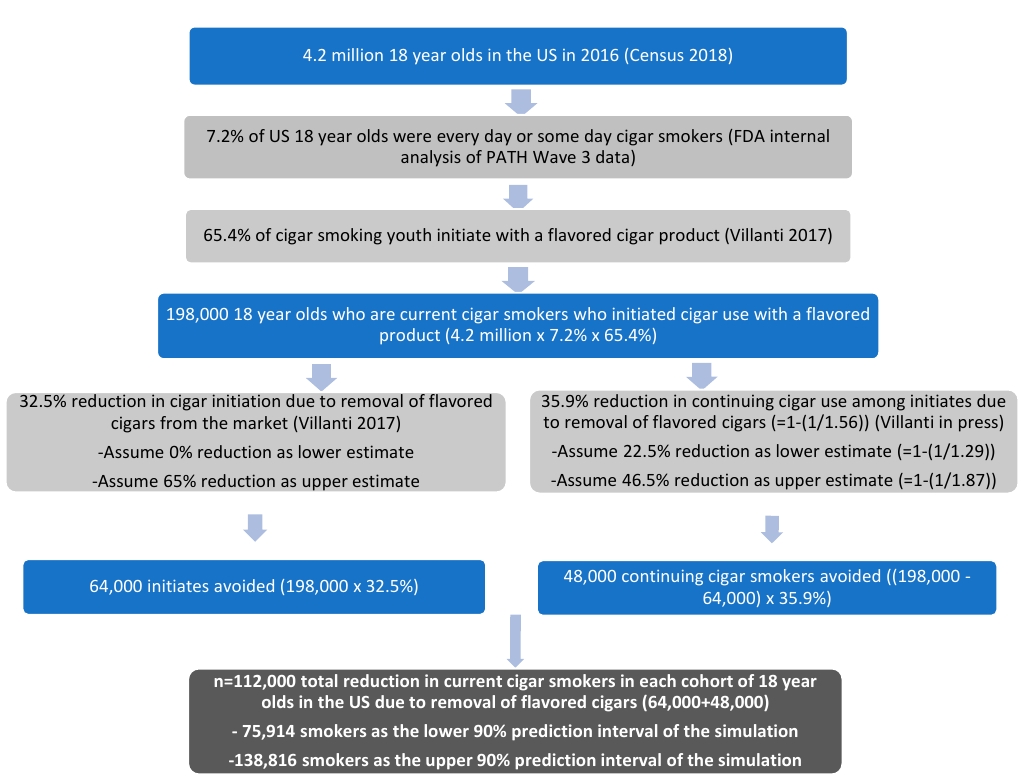
Figure 1. Calculations used to estimate the potential number of new cigar initiates and continuing cigar smokers that may be averted by policies prohibiting flavored cigars throughout the